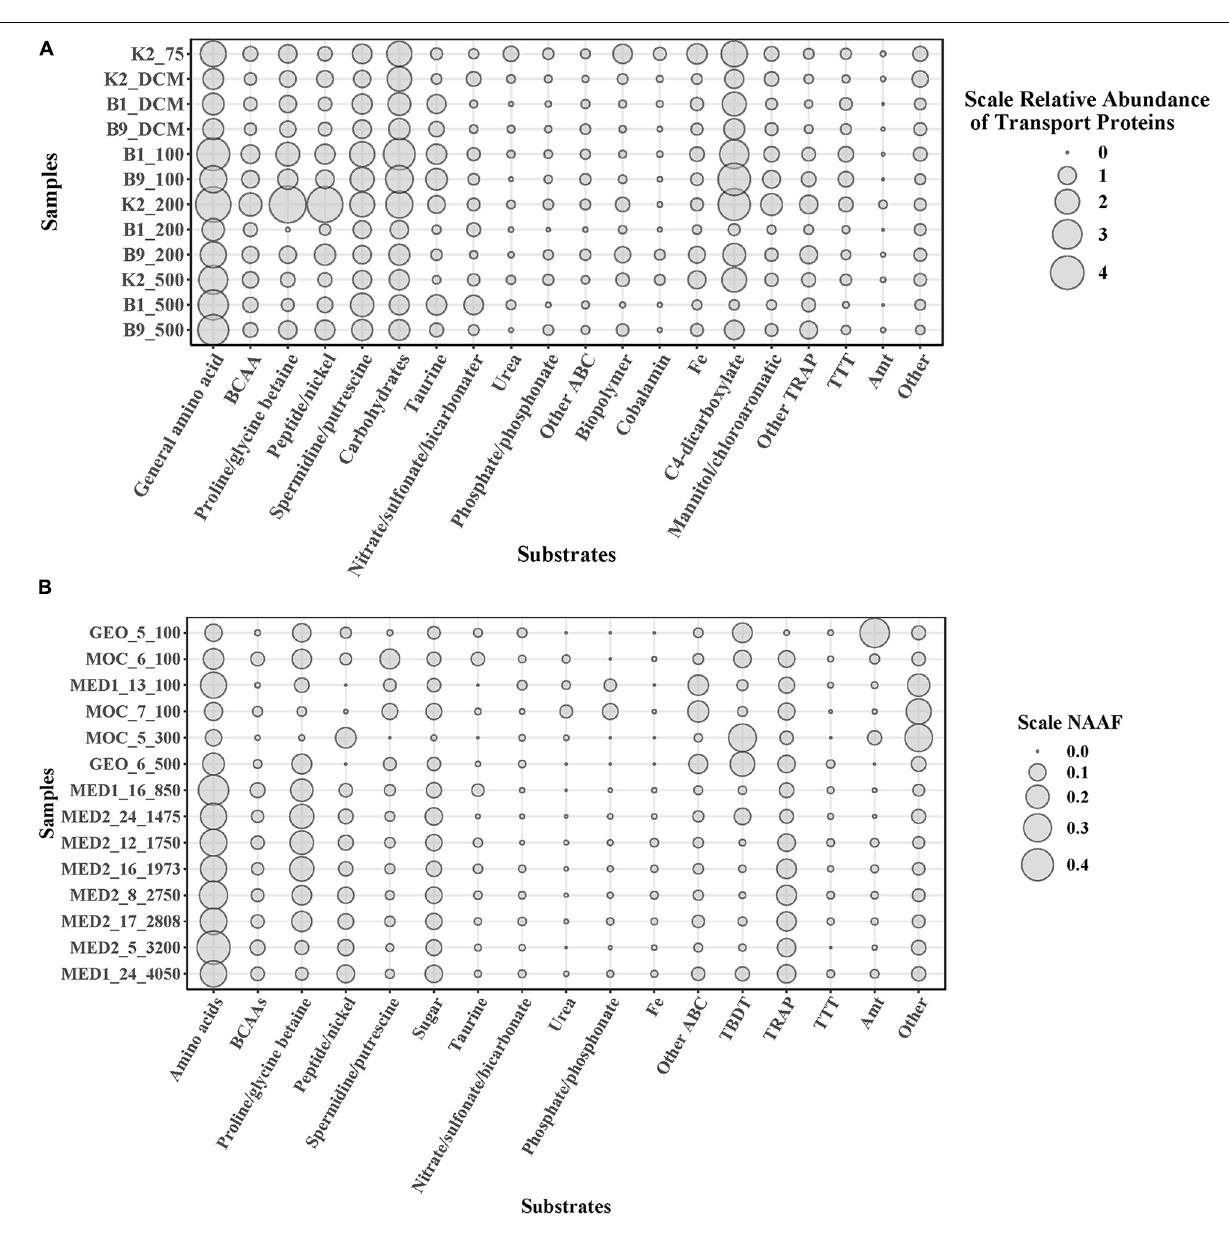
FIGURE 2 | Vertical expression profiles of selected transporters of POM solubilization in northwest Pacific Ocean (A) And transporters of DOM in Atlantic Ocean (B) Analyzed based on NAAF values (Bergauer et al., 2018). Transporter proteins were grouped by the predicted substrate specificity of the substrate-binding proteins. BCAAs, branched-chain amino acids; NAAF, normalized area abundance